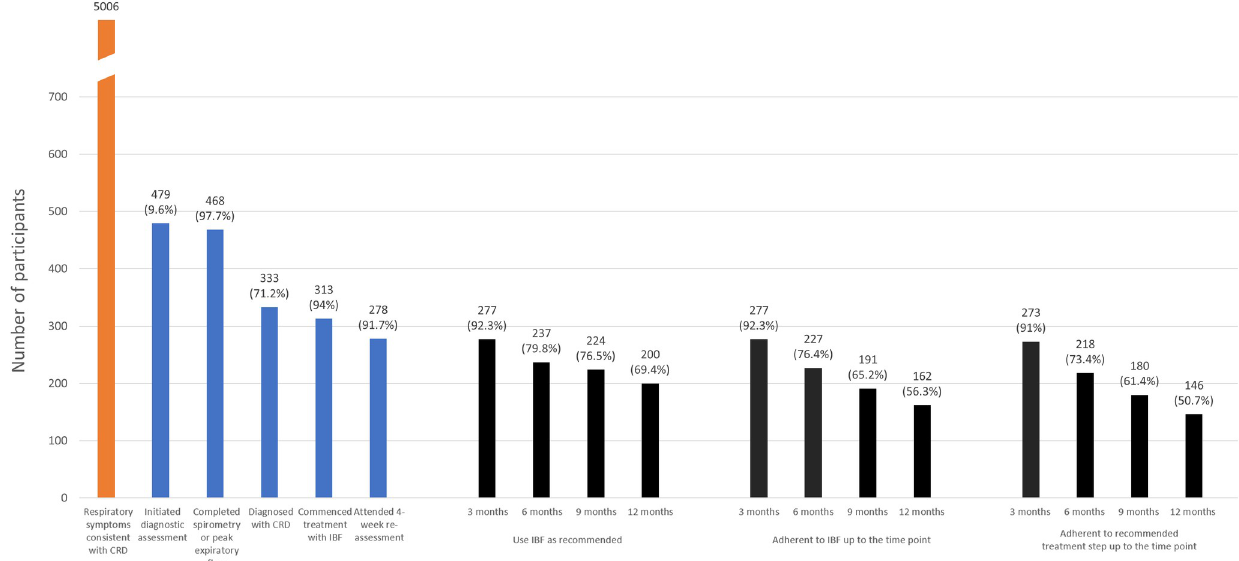
Fig 2. Proportion of patients completing each step of the cascade of intervention. CRD, chronic respiratory diseases; IBF, inhaled budesonide- formoterol.